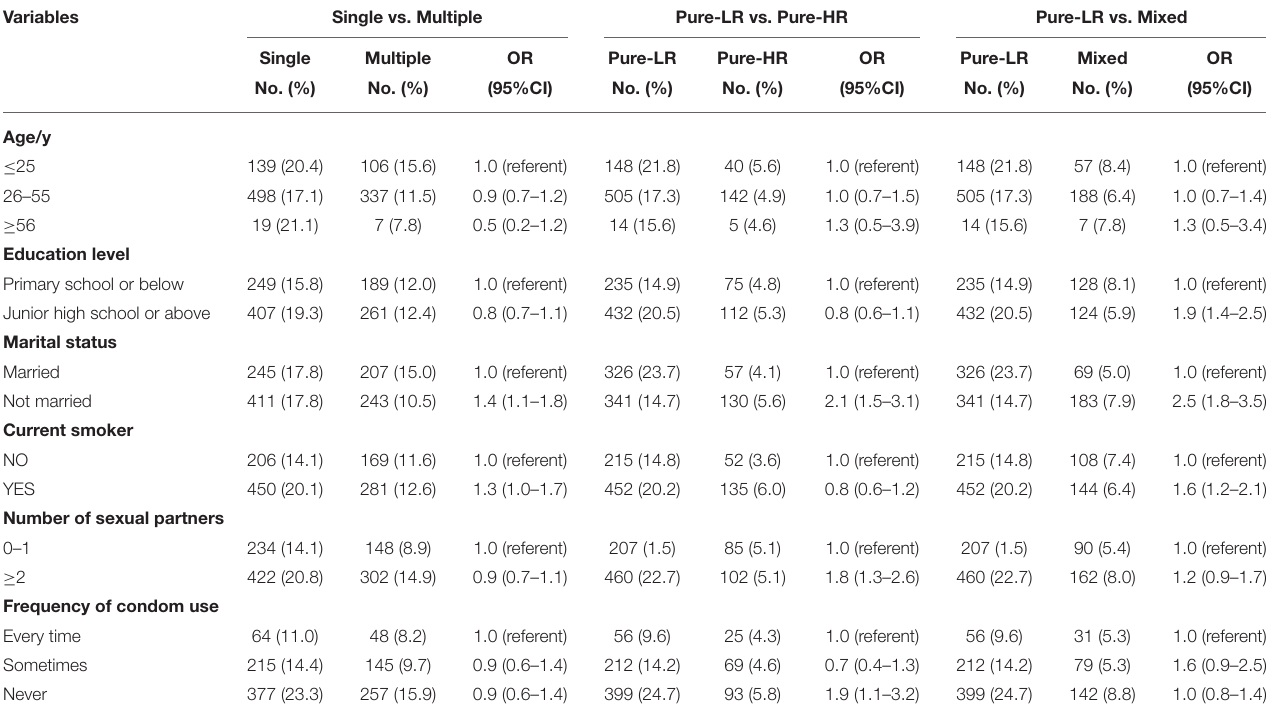
TABLE 3 | Associations of Sociodemographic and Behavioral Characteristics with the Type-specific Human Papillomavirus in 3,690 Men.